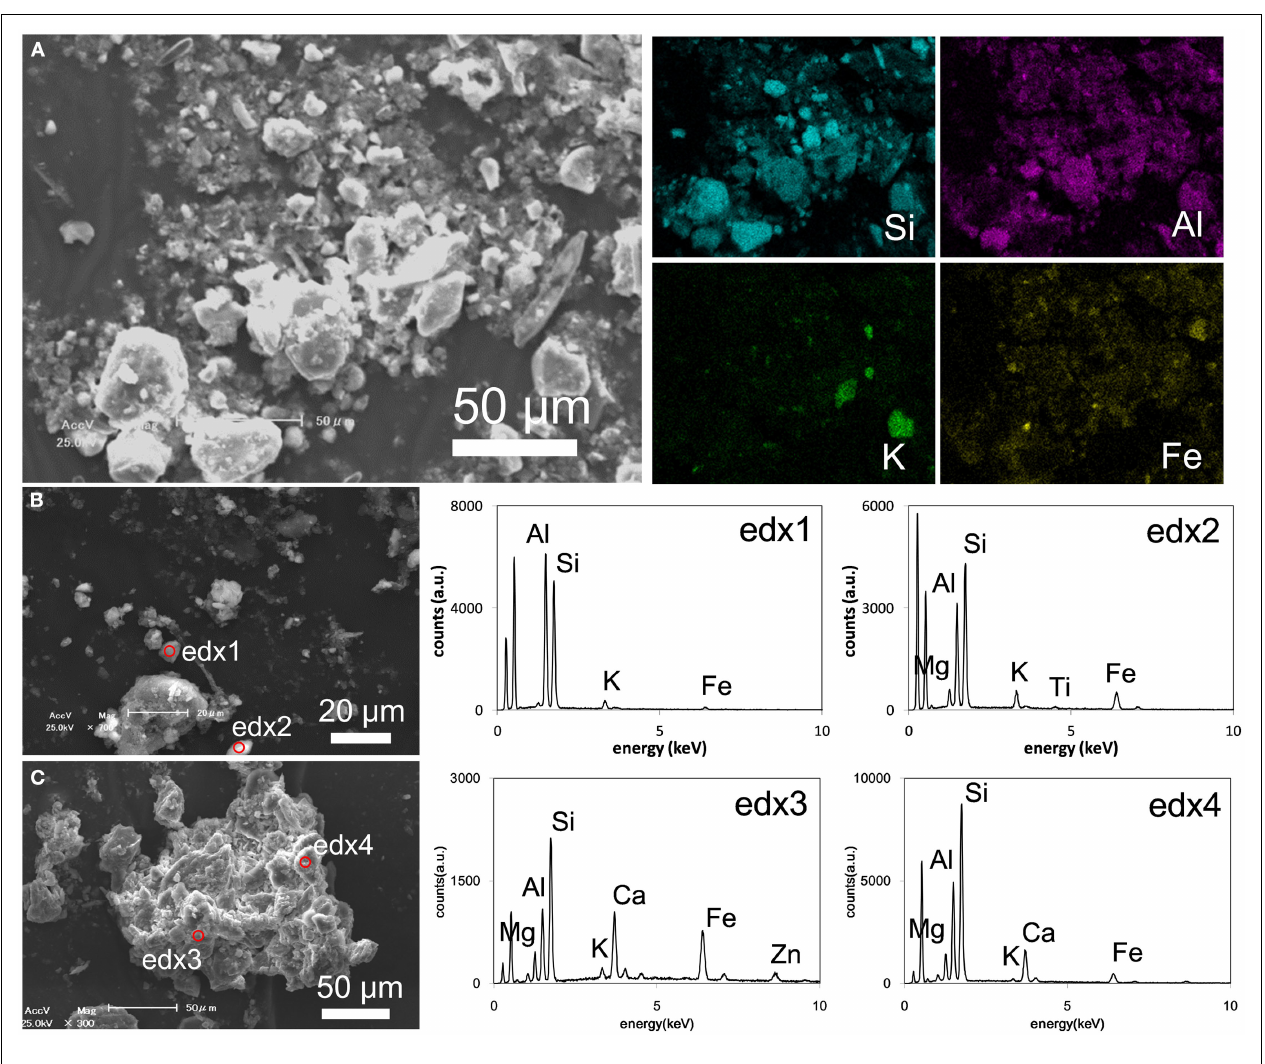
FIGURE 5 | Representative results of SEM analyses . (A) A secondary electron image of OTO-W sample with EDX elemental maps of the same area. (B) A secondary electron image of KOI-E sample with EDX spectra of